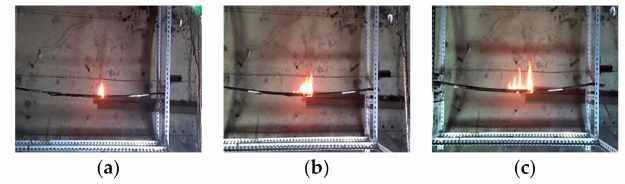
Figure 6. Flame shape of multiple cables with di ff erent cable number. ( a ) Single cable; ( b ) two cables; ( c ) three